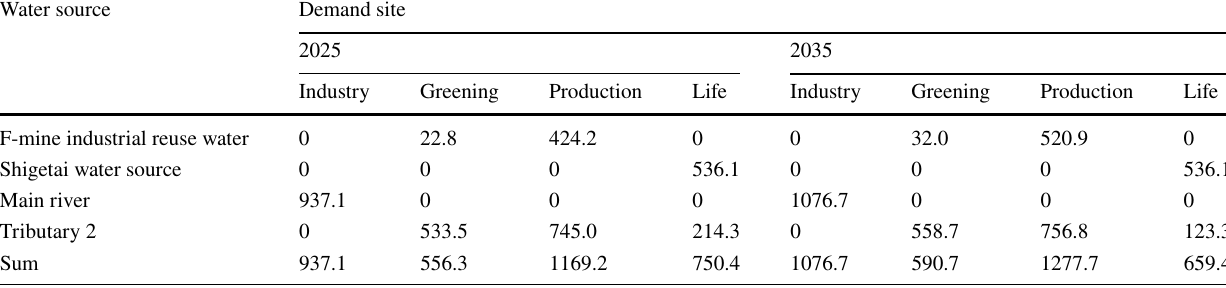
Unit: thousand CMS